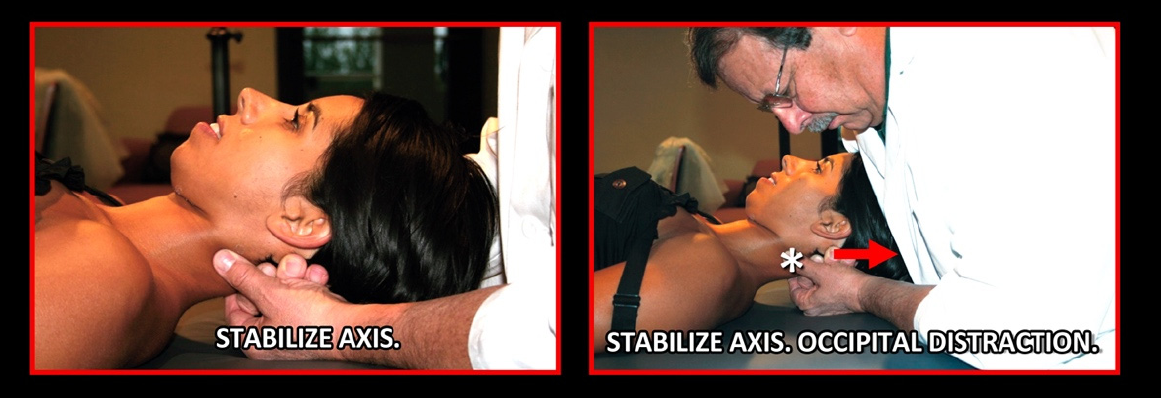
Figure 21. Initial orthopedic manual treatment. Source: Rocabado Institute, Chile. Long axis distraction of the cervical spine (C 0 –C 1 –C 2 ).